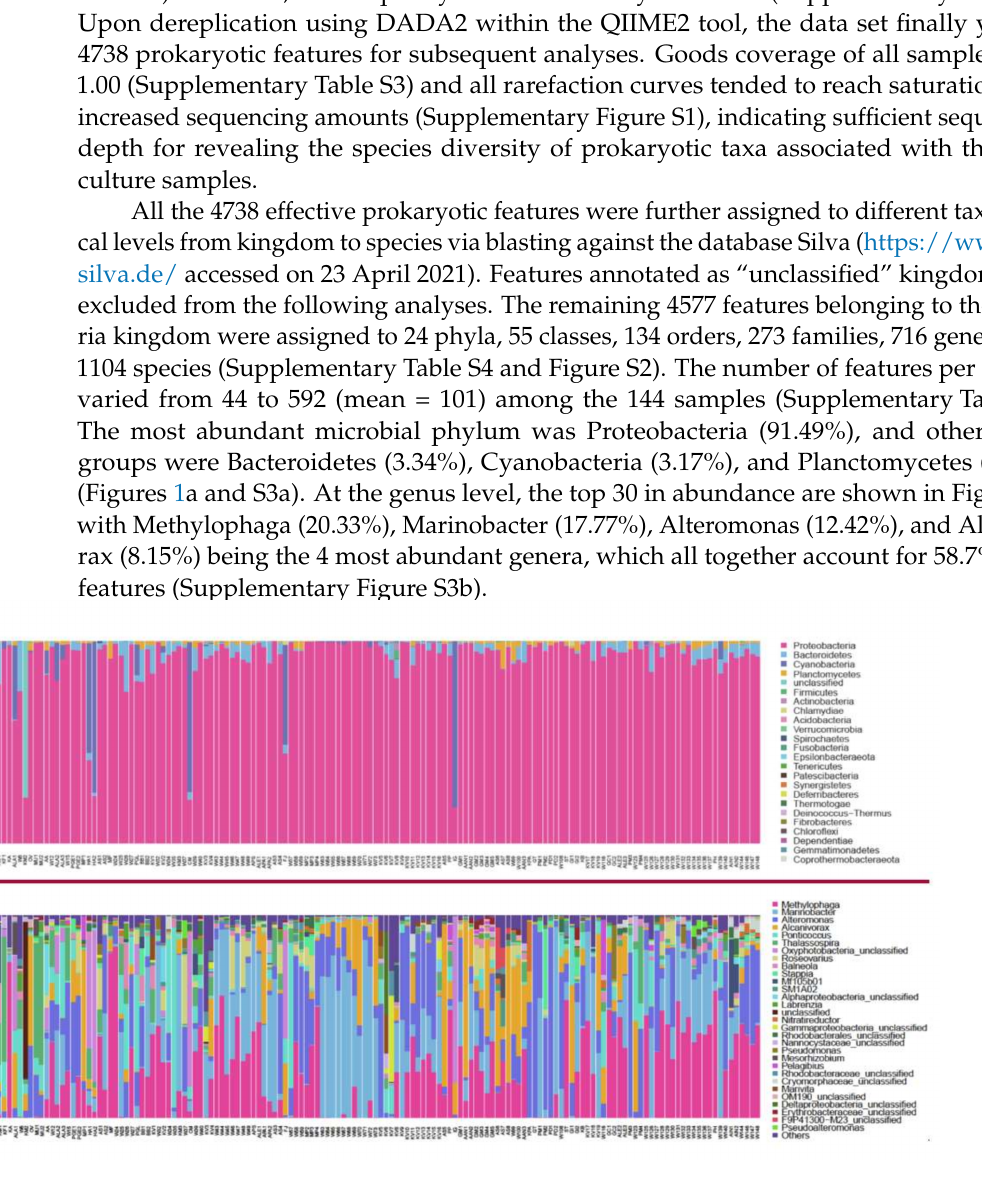
Figure 1. Relative abundance of different phyla ( a ) and genera (top 30; ( b )) in the 144 samples. The abundance is presented in terms of percentage in total effective features in a sample. The order of sample ID on the X-axis is in accordance with that in the “Sample ID” column in Supplementary Table